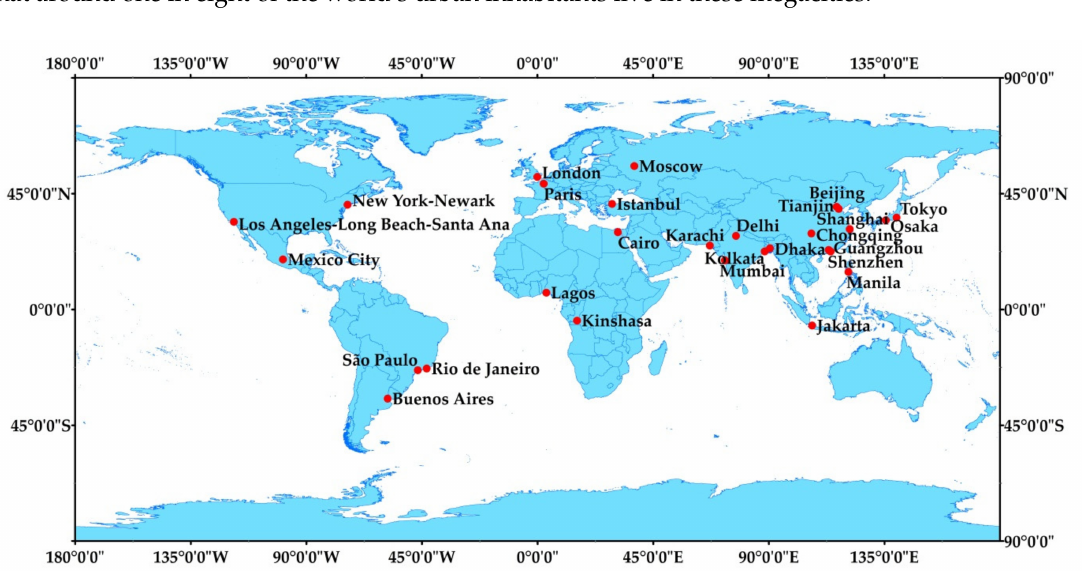
Figure 1. Distribution of the 28 megacities included in this study.